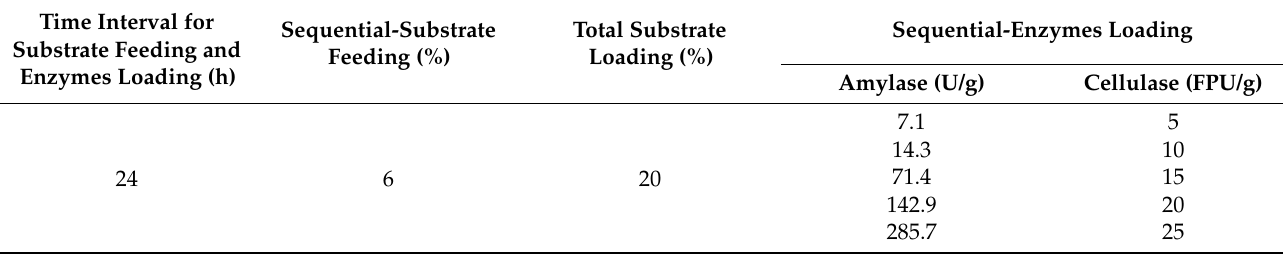
Table 2. Variables for the enzyme loading of amylase and cellulase on the sequential-substrate feeding saccharification. Time Interval for Substrate Feeding and Enzymes Loading